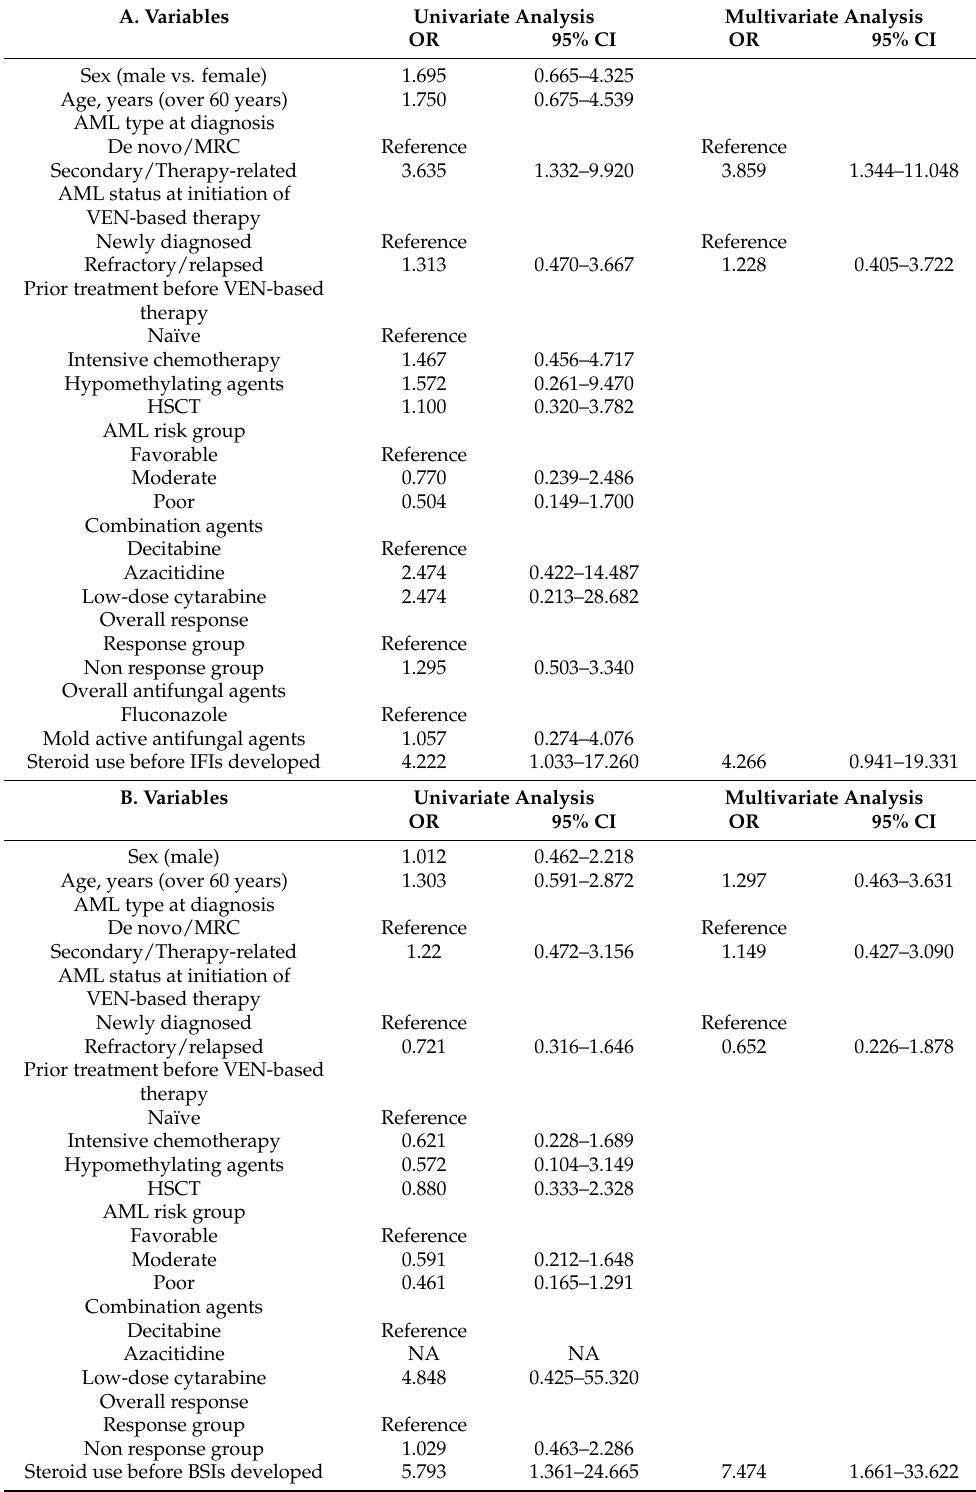
Table 3. ( A ) Risk factors for IFIs during VEN-based combination chemotherapy in univariate analysis and multivariate analysis ( B ) risk factors for